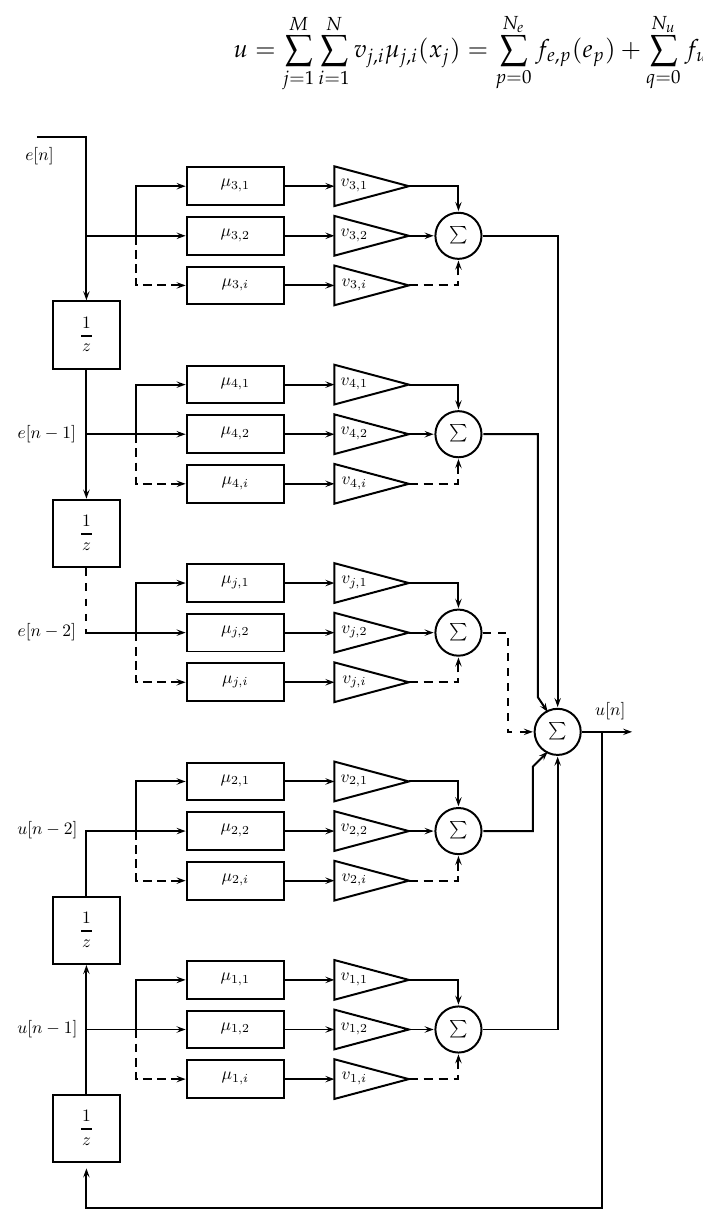
Figure 13. General scheme of the neuro-fuzzy